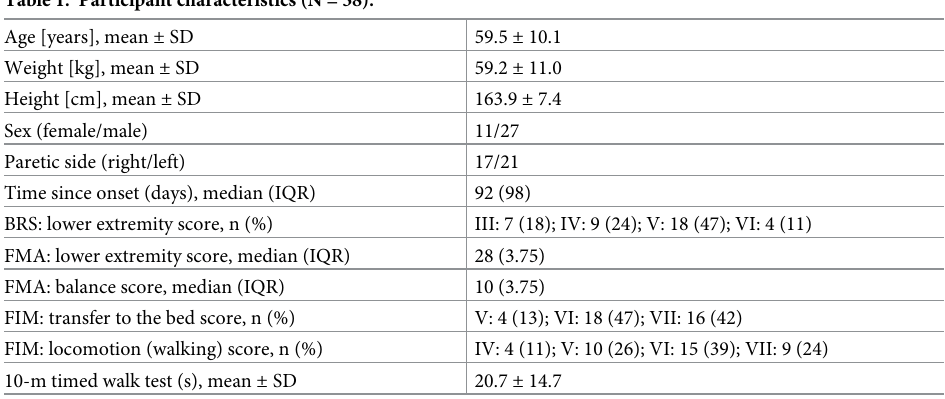
Table 1. Participant characteristics (N =